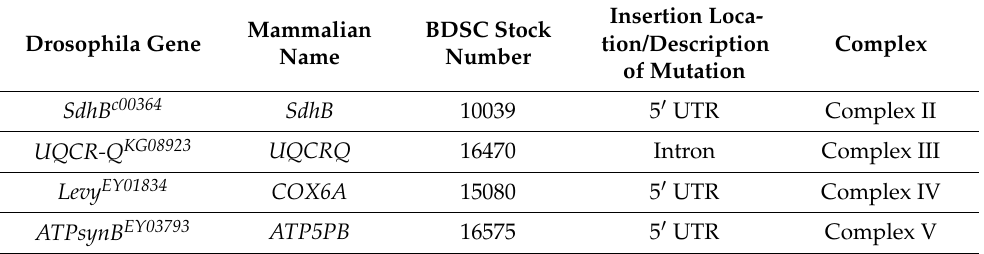
Table 2. Alleles of Complexes II–V screened for hyperoxic ISO toxicity. BDSC: Bloomington Drosophila Stock Center.